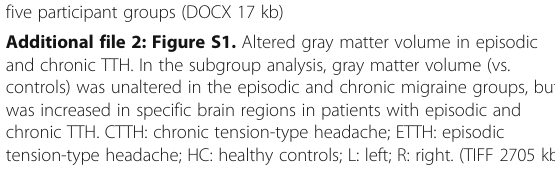
Fig. 4 Receiver operating characteristic (ROC) analysis to distinguish TTH from migraine. In ROC analysis, the gray matter volumes of the left superior frontal gyrus and right cerebellum V combined had excellent discriminative ability for distinguishing TTH and migraine (area under the curve [AUC] =